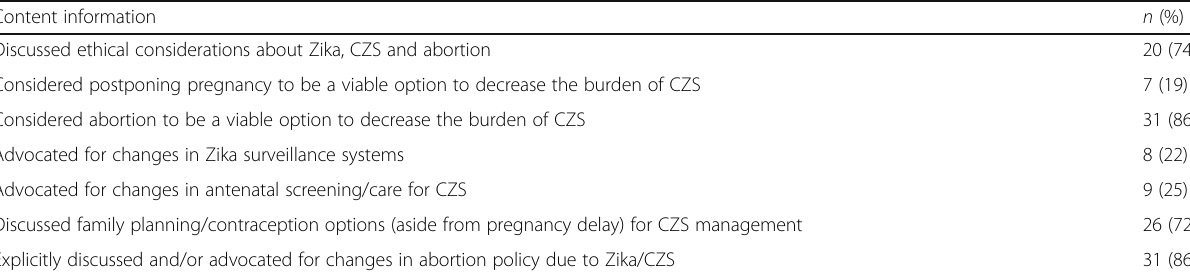
Table 1 Descriptive characteristics of the documents and content information about abortion and Zika Content